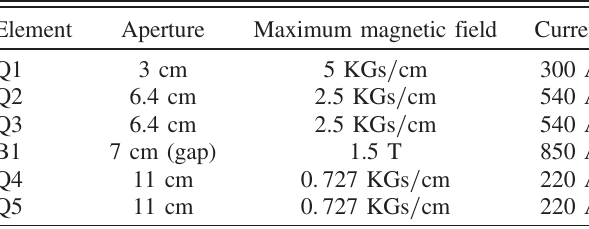
TABLE II. Parameters of quadrupole and sector magnets. Element Aperture Maximum magnetic field Current